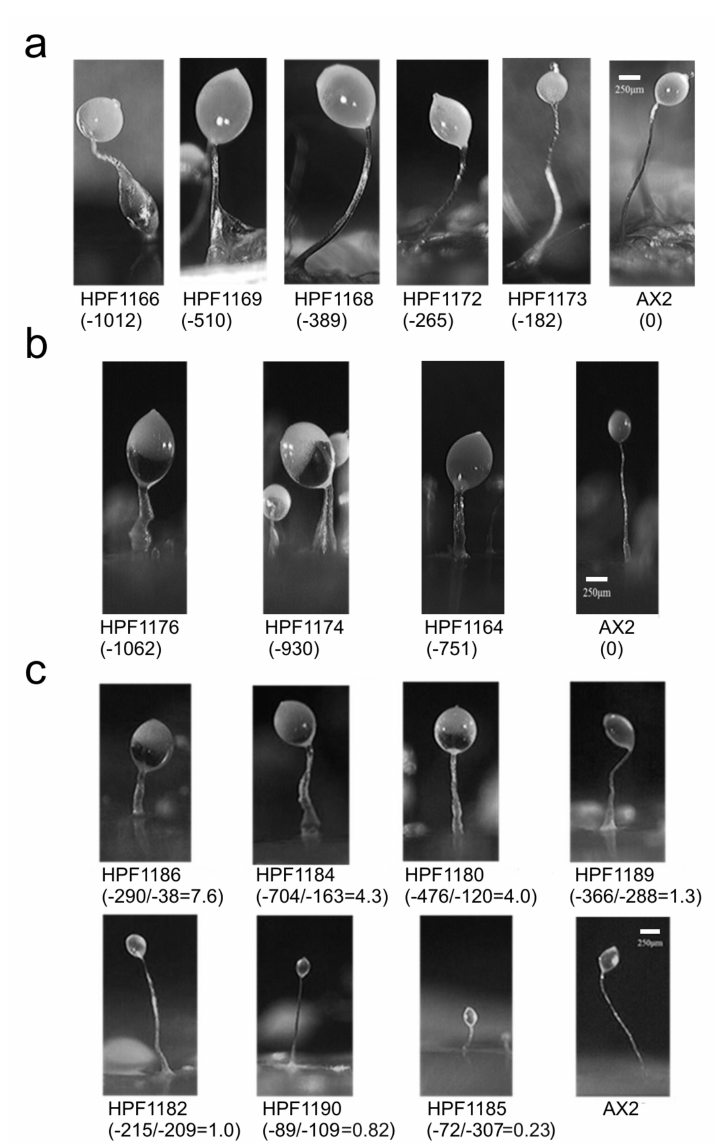
Figure 8. The morphology of the DJ-1 antisense and DJ-1/AMPK double antisense strains under oxidative stress. ( a ): The fruiting body morphology of DJ-1 antisense transformants on KK2 plates containing 900 µ M H 2 O 2 . The numbers in brackets are the copy numbers of the DJ-1 antisense- inhibition construct (pPROF688). Fruiting bodies were larger at higher copy numbers. ( b ): The fruiting body morphology of DJ-1 antisense transformants on SM plates containing 900 µ M H 2 O 2 . The numbers in brackets are the copy numbers of the DJ-1 antisense-inhibition construct (pPROF688). Fruiting bodies were larger at higher copy numbers. ( c ): The fruiting body morphology of DJ- 1/AMPK double antisense cotransformants on SM plates containing 900 µ M H 2 O 2 . The numbers in brackets are the copy numbers of DJ-1 antisense construct (pPROF688) and AMPK antisense construct (pPROF362) and their ratio. As the copy numbers of pPROF688 in DA transformants increased, the fruiting bodies became more defective, with larger sori and thicker, shorter stalks (shown in a , b ). This defect could be rescued in the DAA cotransformants if the ratio of the DJ-1 antisense construct (pPROF688) and the AMPK antisense construct (pPROF362) copy numbers was close to or less than 1. If the ratio was greater than 1, then the amount of AMPK antisense inhibition was not sufficient to restore the defect. At ratios significantly below 1.0, the fruiting bodies became smaller, but appeared normally proportioned. All photographs were taken and all images are presented at the same magnification. All images were taken at the same magnification. Scale bars represent 250 µ